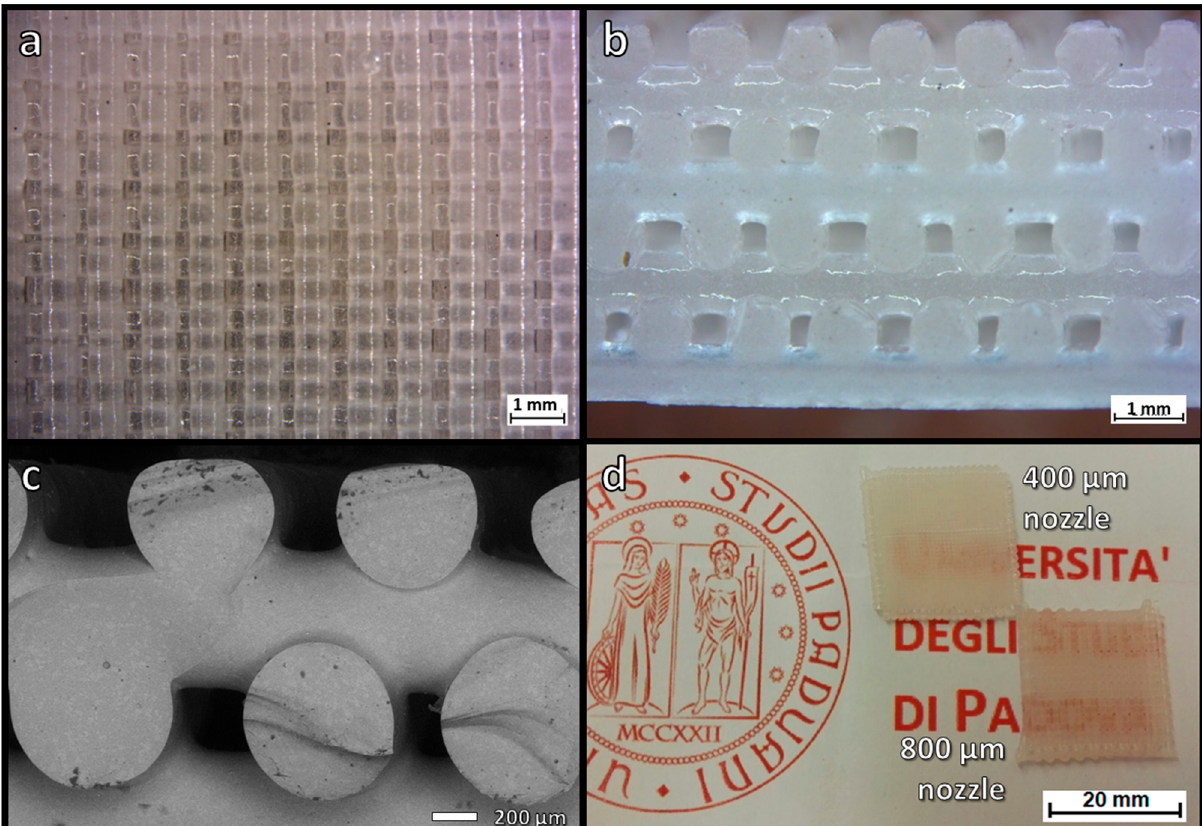
Figure 4. Optical stereomicroscopy top and side views of ‘green’ scaffolds from LCD glass, obtained by extrusion through 400 ( a ) and 800 ( b ) μ m nozzles.